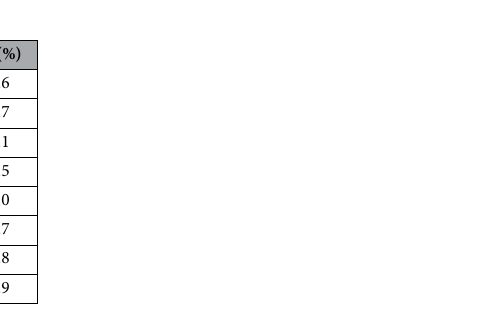
Figure 5. Coverage-dependent properties of the catalytic system under study; results of kinetic Monte Carlo simulations on 11 × 11 lattice with four-cite border averaged over 10 6 runs.